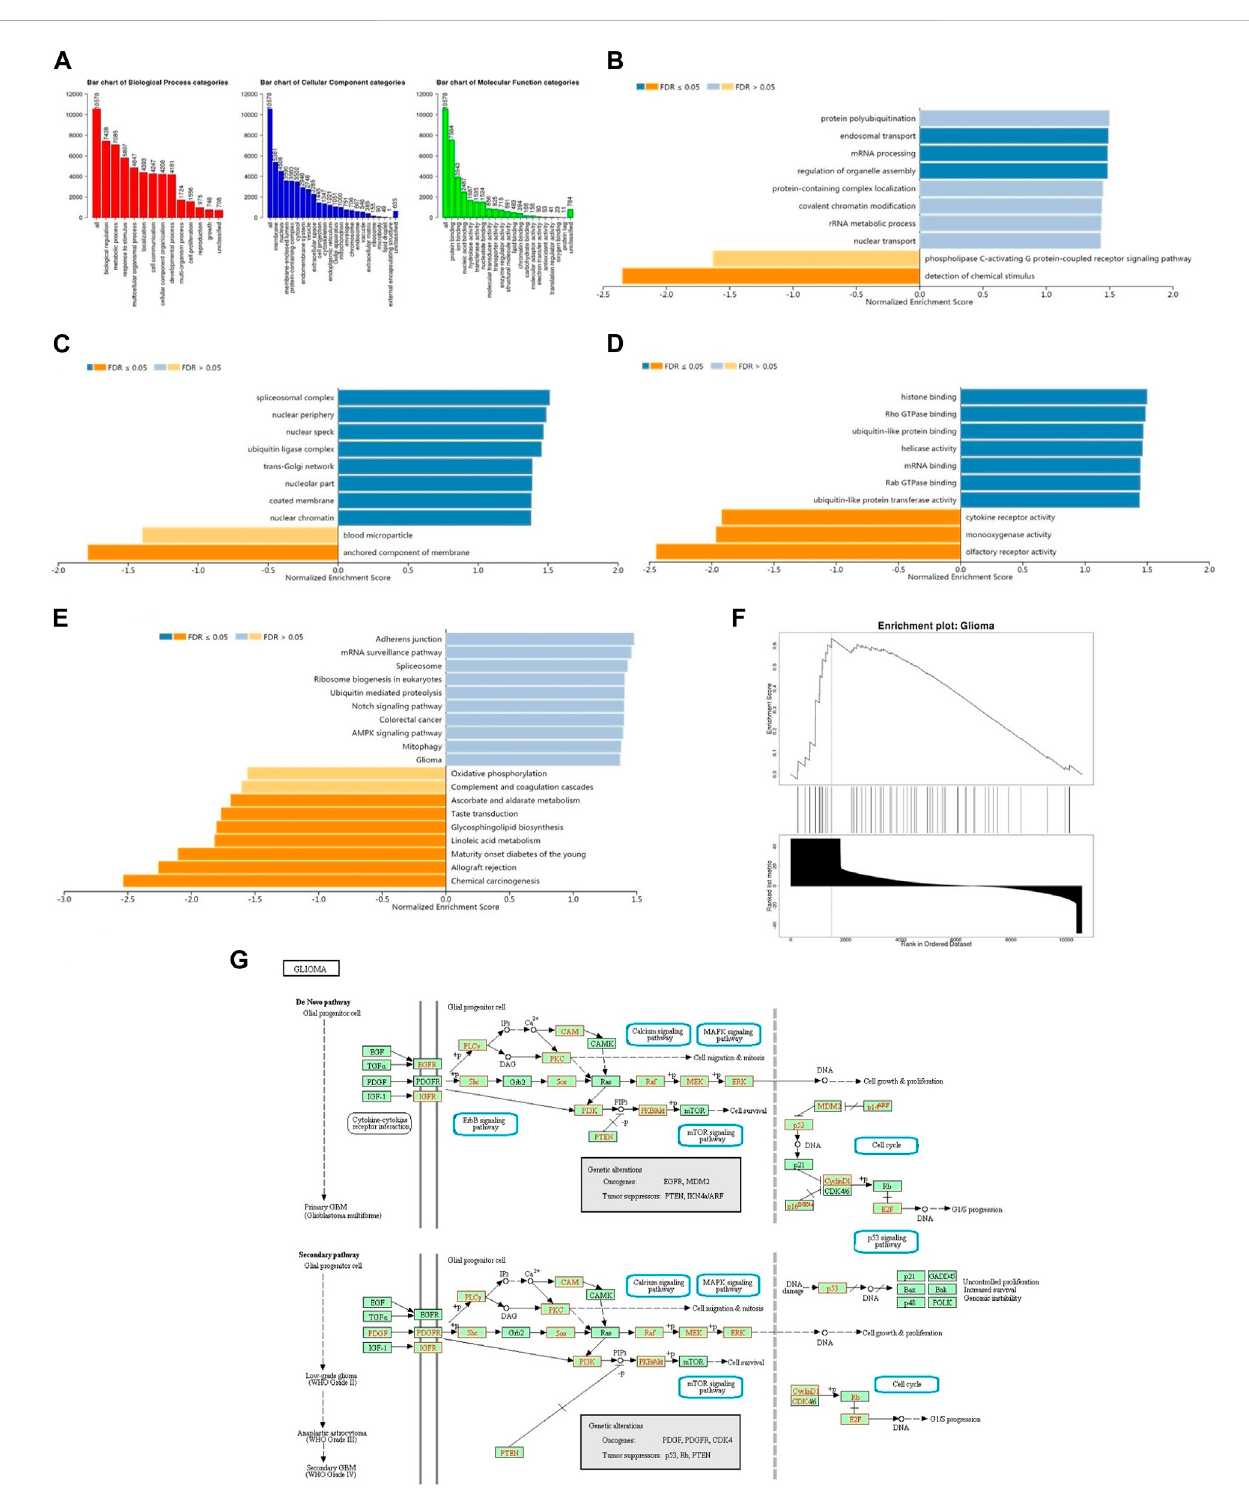
FIGURE 10 The function of BRD4 gene was predicted by the analysis of GO and KEGG in GSEA. (A) The GO enrichment analysis of target genes was predicted from three aspects: biological process (BP), cellular component (CC) and molecular function (MF). (B) The top 10 functional roles of BP for BRD4. (C) The top 10 functionalroles ofCC for BRD4. (D) The top 10 functional roles of MF for BRD4. (E) KEGG analysis ofdifferentially expressed genes. (F) Enrichment analysis of KEGG pathway showed the regulation pathway of Glioma. (G) KEGG annotations of the Glioma pathway regulated by BRD4 in brain cancer (cBioPortal). Targets marked in red were related to the Leading Edge